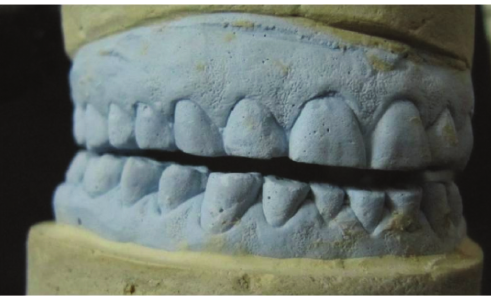
Figure 4: Restoration of vertical dimension on